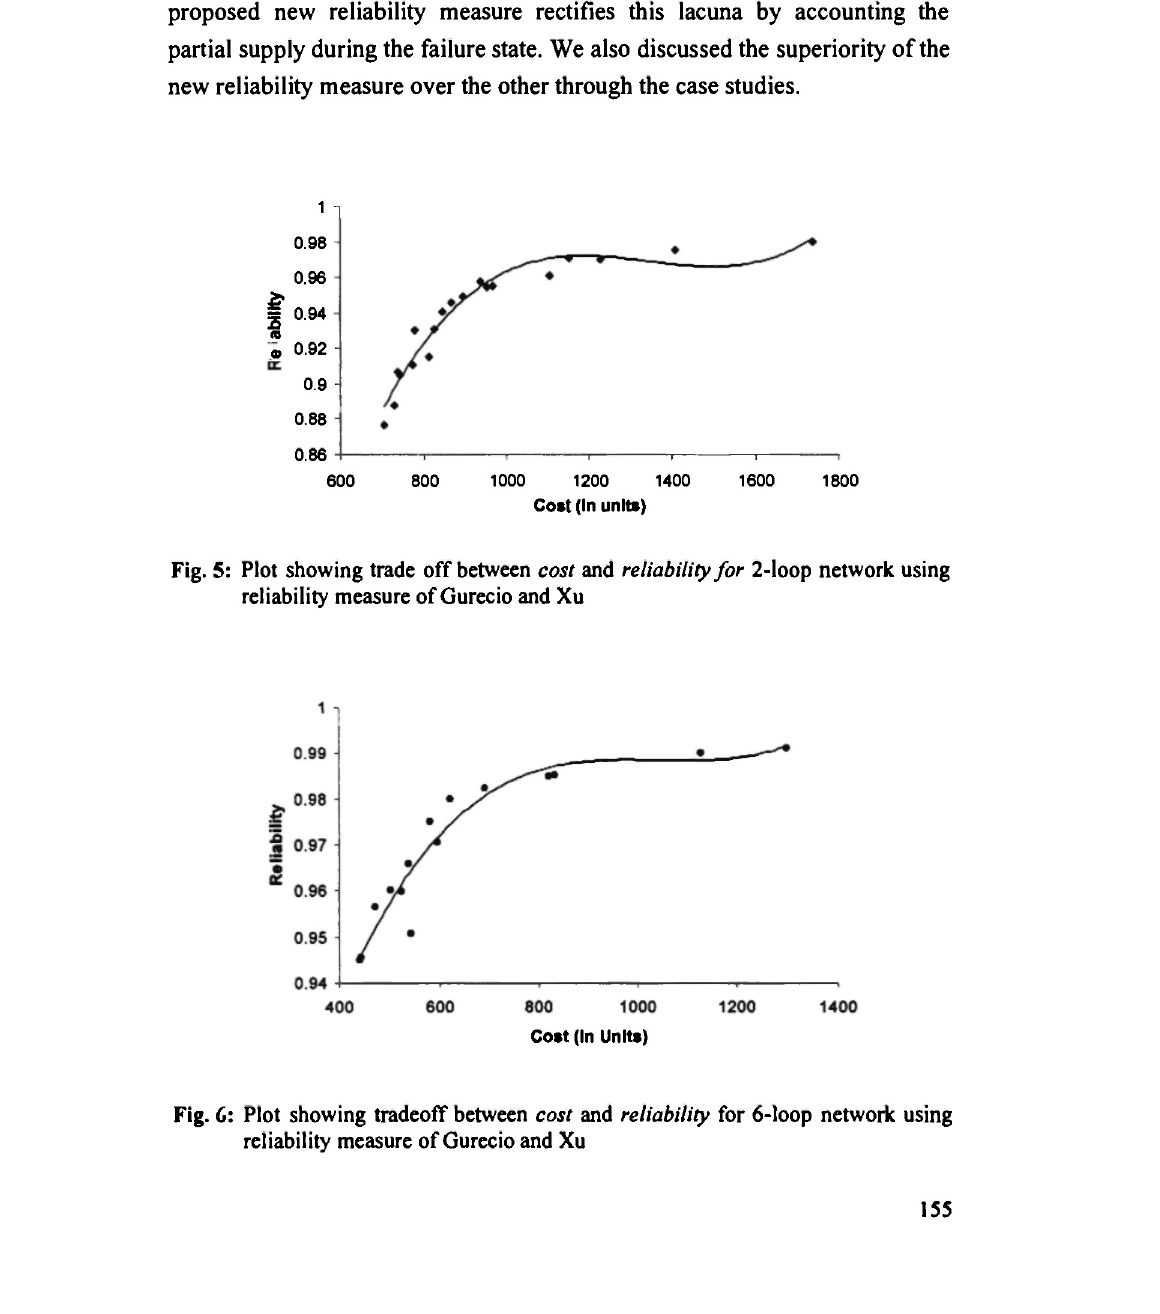
Fig. 6: Plot showing tradeoff between cost and reliability for 6-loop network using reliability measure of Gurecio and Xu